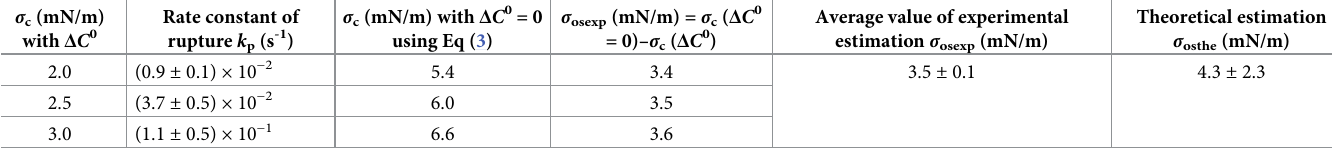
Table 4. An estimation of membrane tension of DOPG/DOPC (40/60)-GUVs for Δ C 0 = 17 mOsm/L and C out = 371 mOsm/L. Rate constant of σ c (mN/m) with Δ C 0 rupture k p (s -1